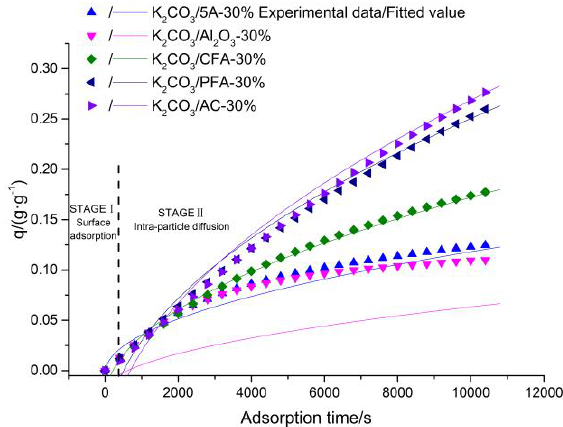
Figure 13. Fitting of intra-particle diffusion kinetic equation.